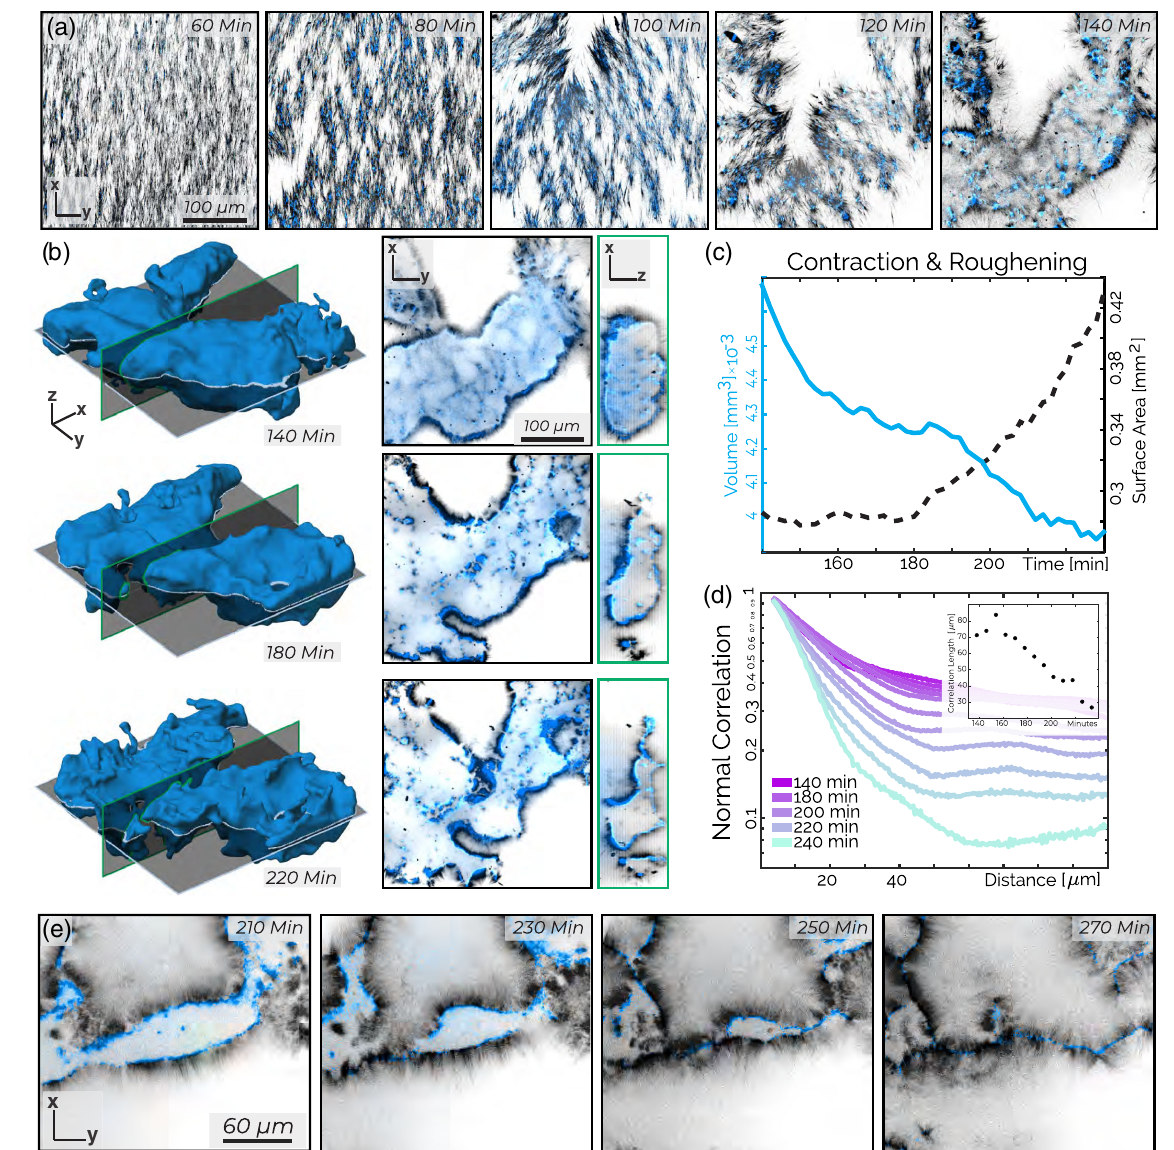
FIG. 6. Active foam: splaylike deformations, self-tearing, and roughening at the highest microtubule concentrations. (a) Maximum intensity z projections over 3 μ m show a splaylike instability that generates density variation and self-tearing that yields condensates. (b) Evolution of a contracting condensate surface (left) x - y and x - z image cross sections (right). (c) The volume (solid blue curve) and surface area (black dashed curve) of a contracting condensate as a function of time. (d) The spatial correlation between surface normal vectors decay over time. Inset: Exponential fits to the normal-normal correlation decay between 5 and 20 μ m show correlation length decreases by 50 μ m over 80 min. (e) Two surface-bound monolayers zippering into a bilayer. The sample contains 200 nM kinesin (blue) and 40 μ M tubulin